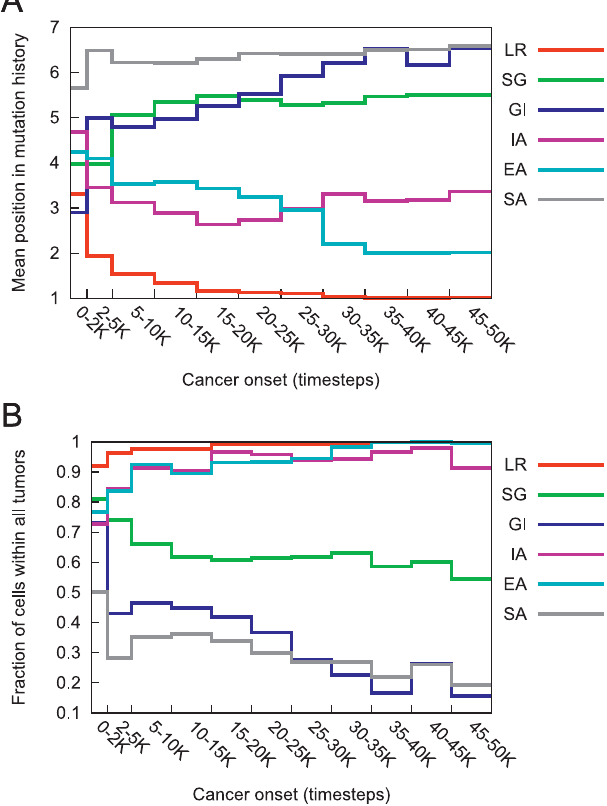
Figure 2. Pathways to Cancer Vary with the Timing of Cancer Onset (A) Average position of the mutations in the pathways present in the 986 runs that terminated in cancer, for tumors acquired in the timeblocks specified on the x -axis. A position of one indicates that it was the first mutation of a pathway. A position of seven indicates that a given mutation did not appear in the pathway. For cancers arising before 2,000 time steps, GI was frequently the first mutation, as it has the lowest mean position. As time progresses and telomere length shortens, LR becomes the first mutation in all pathways. Standard deviation and sample size data are included in Table S2. (B) Fraction of all cells in all tumors carrying a given mutation, in which cancer onset occurred in the timeblocks specified on the x -axis. Cells with mutations in LR, IA, and EA make up the majority of the tumors. The frequency of GI drops substantially as time of cancer onset increases, whereas the frequency of SA remains low for all timeblocks. DOI: